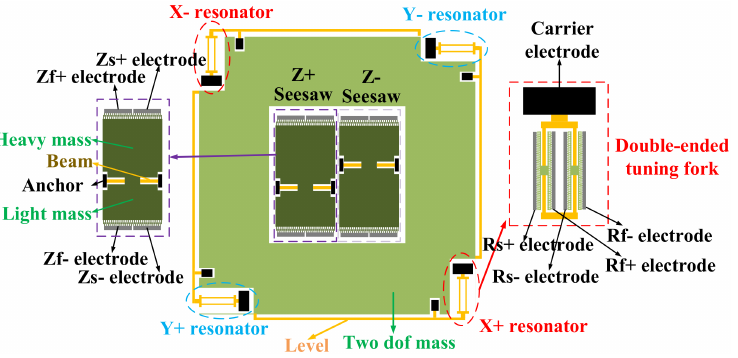
Figure 1. The structure of the